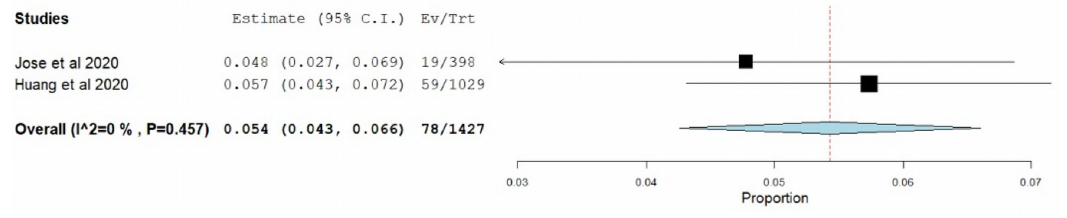
Fig 7. Forest plot of the overall pooled prevalence of low resilience.